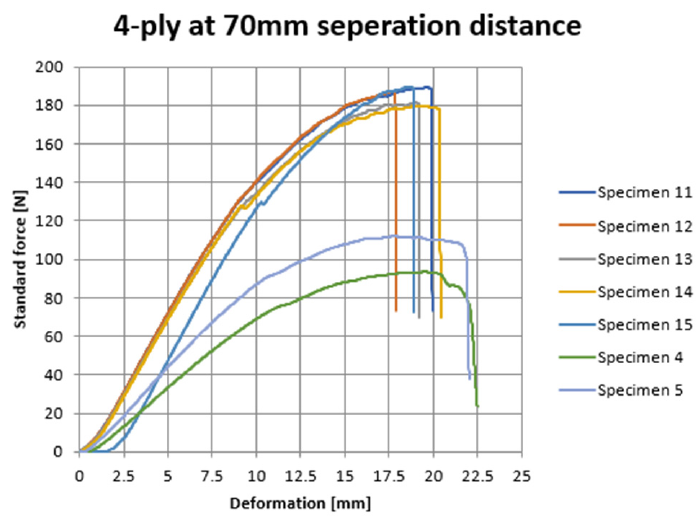
Figure 2. Deformation profile for a 4-ply samples.